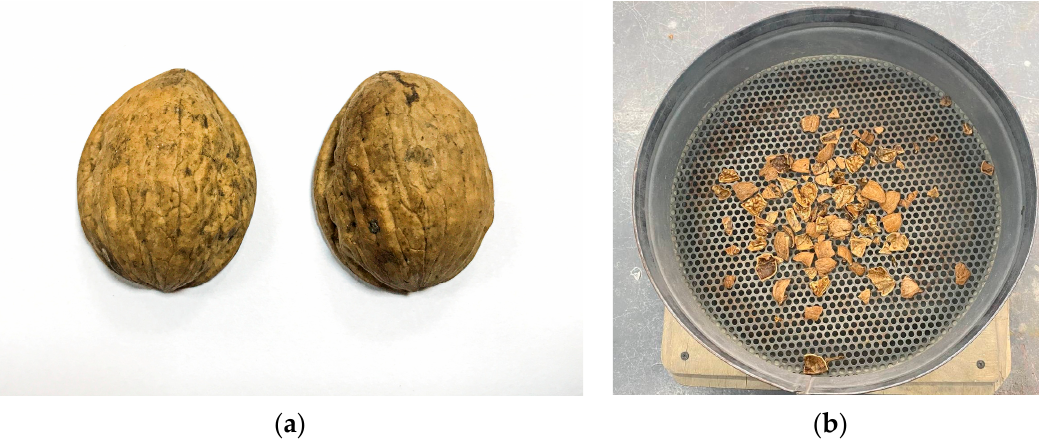
Figure 3. Appearance of the walnut shell: ( a ) whole; ( b ) crushed to sizes from 5 to 20 mm.